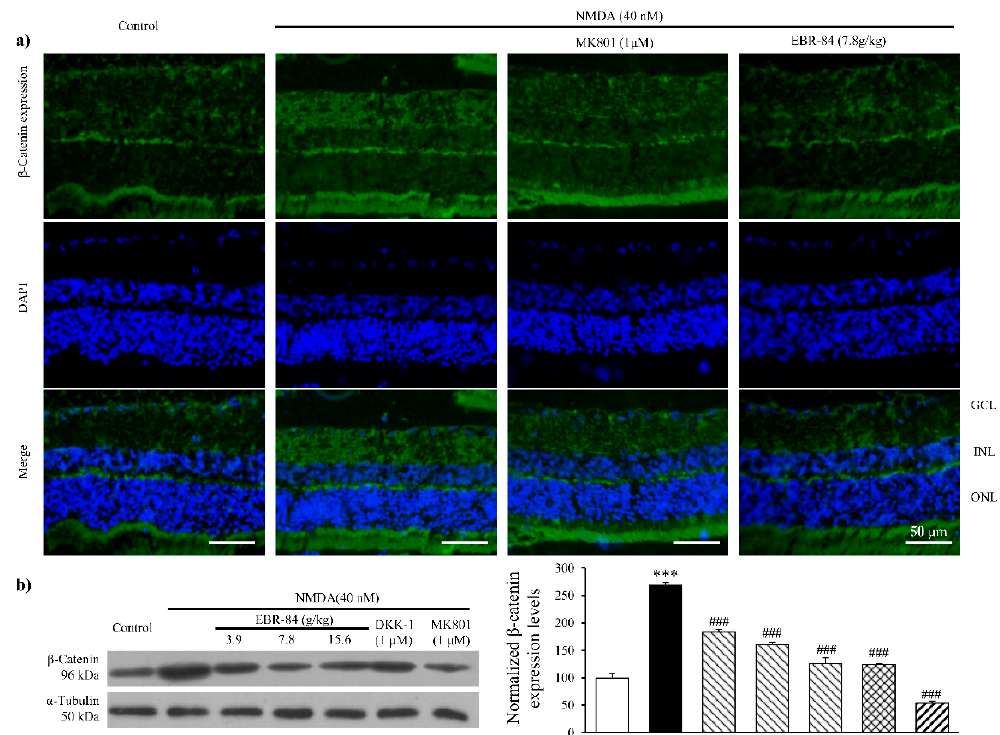
Figure 3. The effect of EBR-84 on β -catenin retinal expression in the RGCL of NMDA-treated rats. ( a ) Representative images of immunofluorescence staining for β -catenin expression in the rat retinas. ( b ) The determination of the nuclear β -catenin protein level in the rat retinas tested using Western blot analysis ( n = 5). *** p < 0.001 vs. the control group; ### p < 0.001 vs. the NMDA group. The magnification of all figures is ×200. Scale bar is 50 μ m for all images.